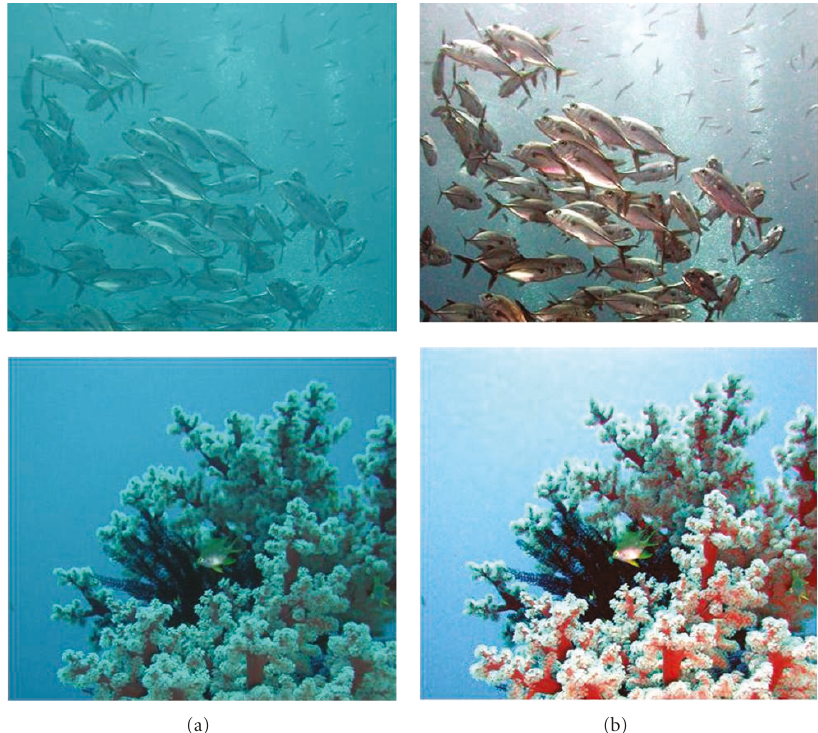
Figure 8: Original images (a), images after enhancement using Iqbal et al’. technique (b). Image courtesy of Iqbal et al.